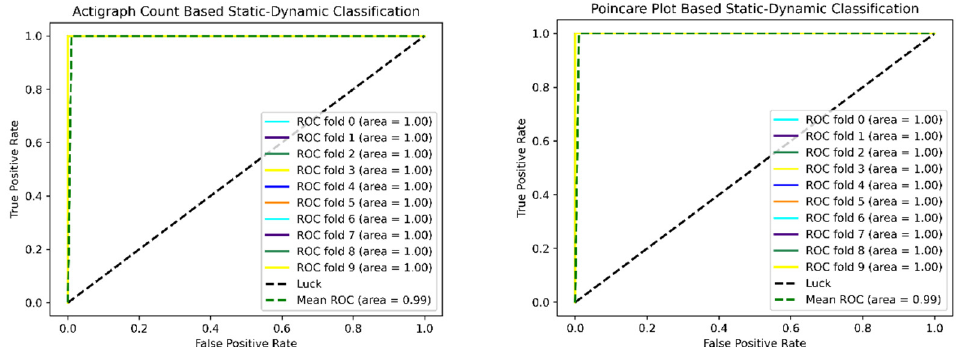
Figure 9. ROC curve for static and dynamic classification. The left panel denotes the ROC curve for the Actigraph count-based static and dynamic activities’ classification. The right panel denotes the Poincare plot-based static and dynamic activities’ classification.